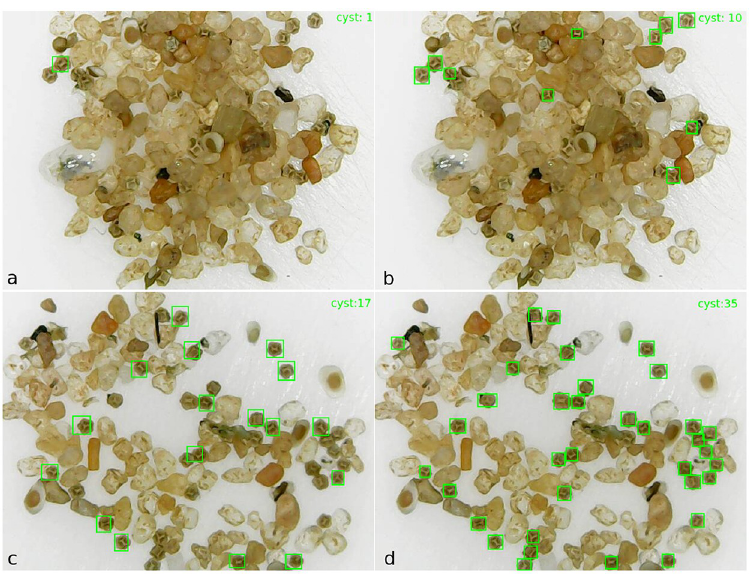
Fig 7. Example of detecting and counting cysts of the Faste R-CNN and YOLOv3 architectures: a) The Faster R-CNN detected and counted only 1 of 20 cysts in the image; b) The YOLOv3 detected and counted 10 of 20 cysts in the image; c) The Faster R-CNN detected and counted 17 of 36 cysts in the image; d) The YOLOv3 detected and counted 35 of 36 cysts in the image.